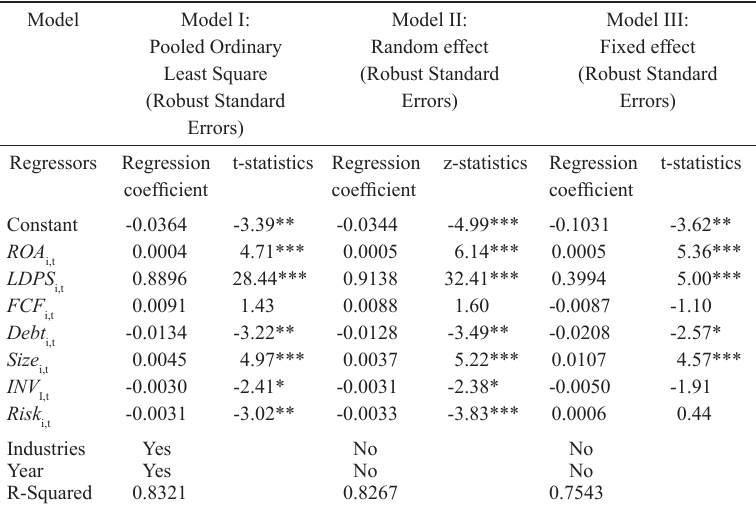
Panel Ordinary Least Square, Random Effect and Fixed Effects (with Robust Standard